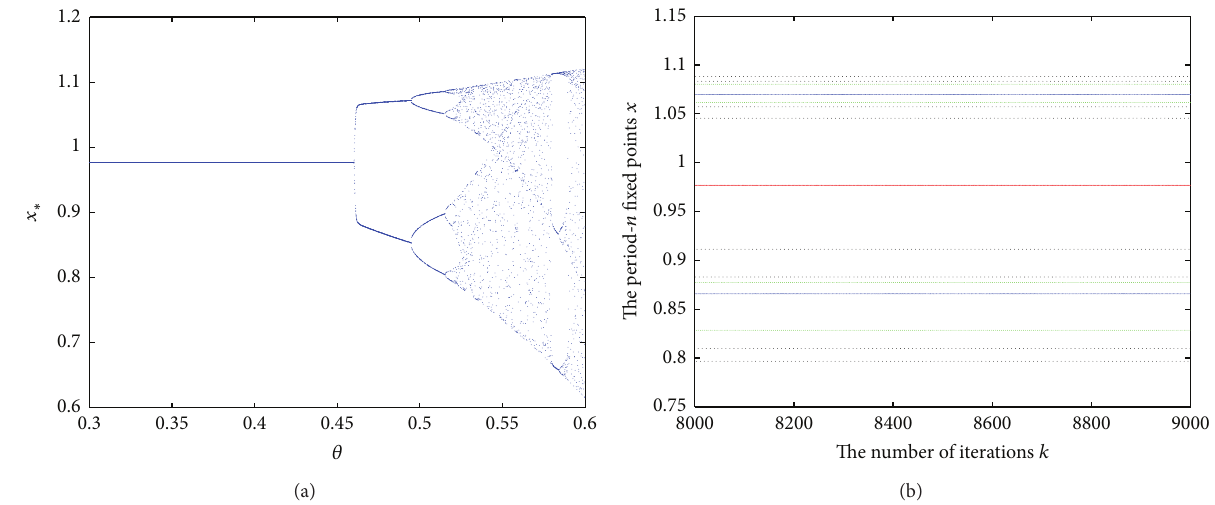
Figure 2: (a) The bifurcation diagram of system (4) with 𝜃 varying in (0.3, 0.6) . The system undergoes a flip bifurcation when 𝜃 ≈ 0.456 . (b) With 𝜃 increasing, system (4) undergoes period-1 point (red line corresponding to 𝜃 = 0.36 ), period-2 points (blue dot lines corresponding to 𝜃 = 0.46 ), period-4 points (green dot lines corresponding to 𝜃 = 0.5 ), and period-8 points (black dot lines corresponding to 𝜃 = 0.518 ).